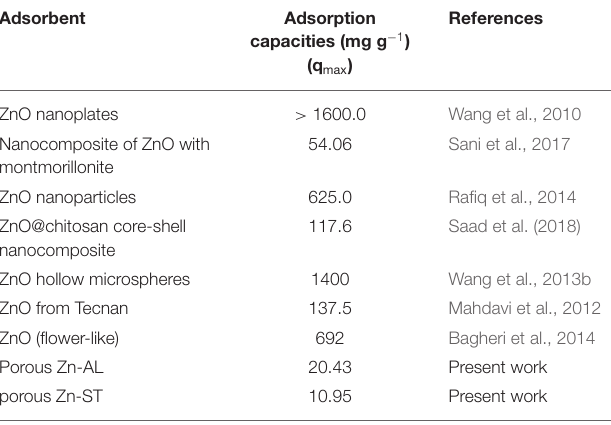
TABLE 2 | Reported adsorption capacities (mg g − 1 ) of copper using Zinc Oxide as adsorbent.